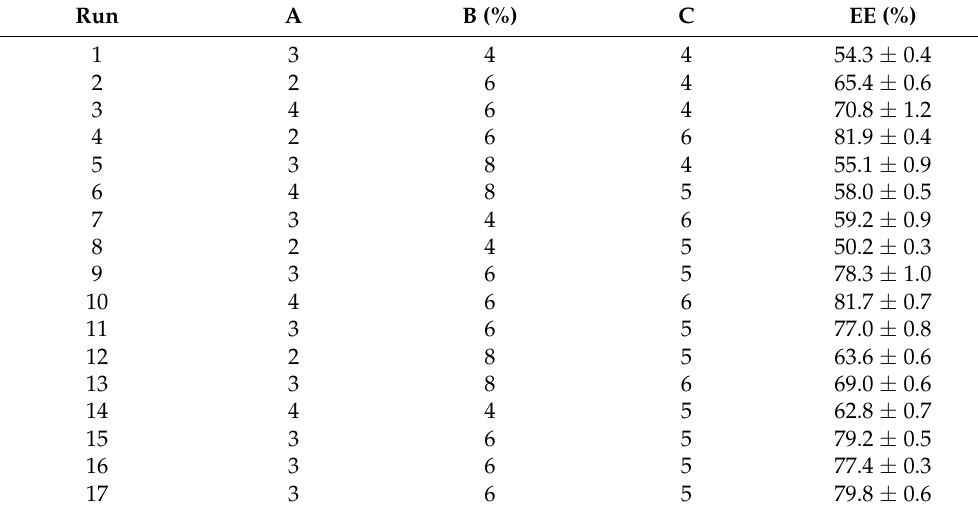
Table 1. Box–Behnken experimental design and results.